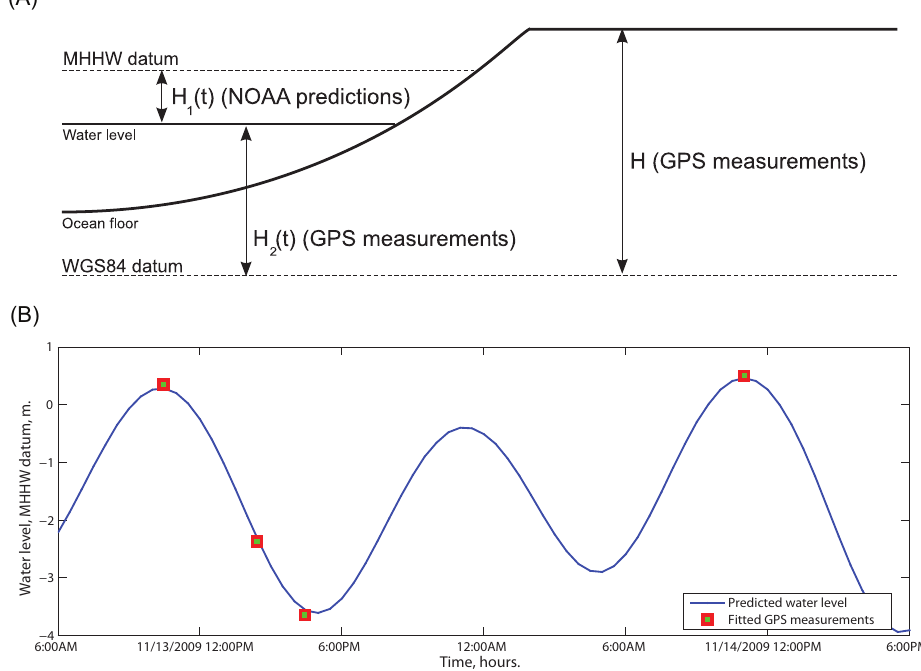
Fig. 6. (A) Measurement of sea level in the WGS84 datum and the relation of the WGS84 datum to the MHHW datum. (B) Predicted water level dynamics in Whittier and the fitted GPS measurements of the water level in the MHHW